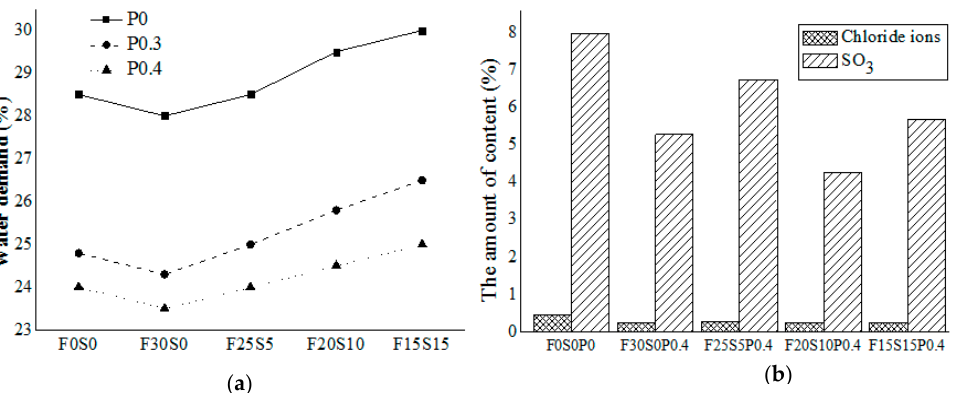
Figure 3. ( a ) Water demand for cement paste specimens and ( b ) the amount of chloride ion and SO 3 content of the samples.